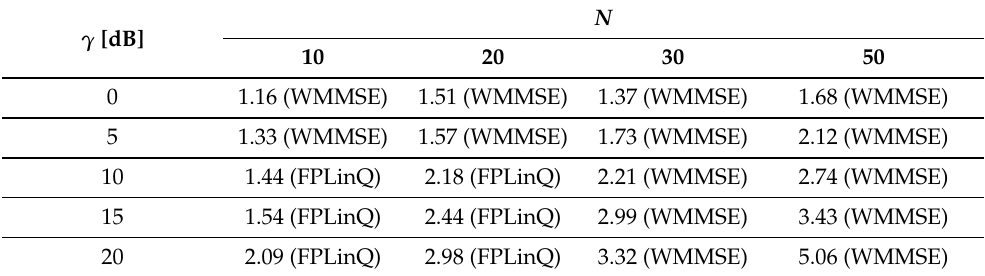
Table 2. The average energy-efficiency ratio of the proposed scheme to the best performing reference scheme. The schemes in parentheses also denote the reference scheme with the highest energy efficiency. γ [dB]